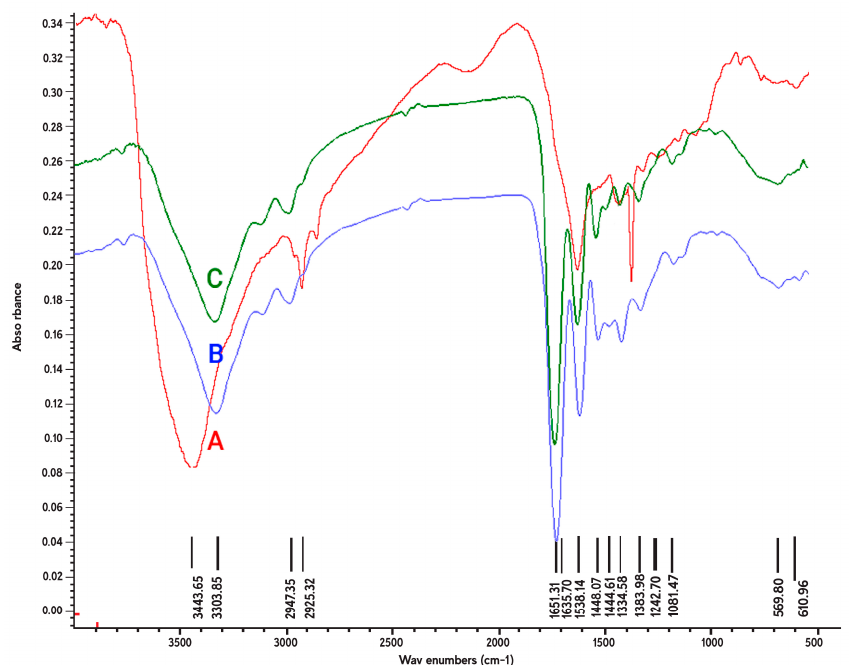
Figure 3. The attenuated total reflection Fourier transform infrared (ATR-FTIR) spectra of ( A ) crosslinked gelatin nanofibers before plasma treatment, ( B ) argon plasma treated nanofibers and ( C ) argon–oxygen plasma treated